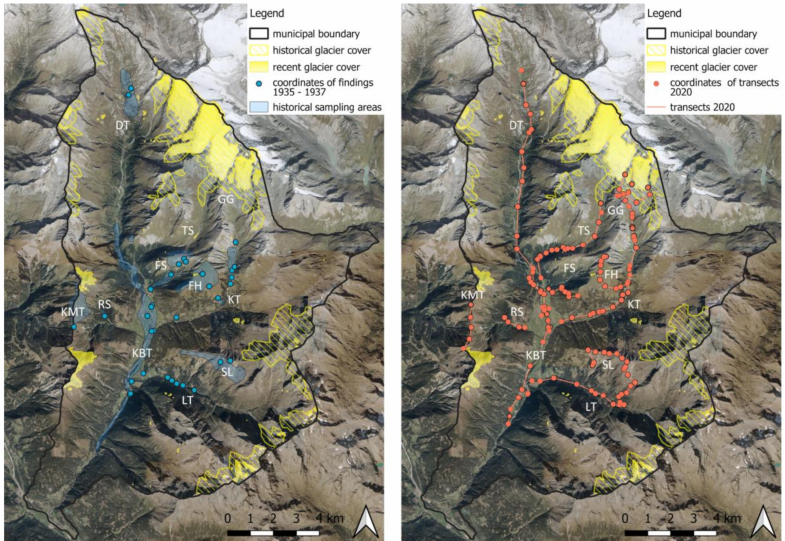
Figure 1. Sampling areas around Kals am Großglockner. The left plot shows the locations from 1935 and 1937 (blue dots) and the right plot the surveyed transects in 2020 (red dots and transects). Historical glacier cover is shown in yellow dashed areas [44], and recent glacier cover in yellow filled areas [50]. The abbreviations of the sampling sites are as follows: Kalsbachtal (KBT), Lesachtal (LT), Ködnitztal (KT), Foledischnitz (FS), Teischnitztal (TS), Dorfertal (DT), Raseggbachtal (RS), Kals- Matreier-Törl (KMT), Schönleitenspitze (SL), Figerhorn (FH), and base of the mountain Großglockner (GG). The municipal boundary is shown in black (data: community boundary—BEV, 2019, basemap.at, accessed on 5 January